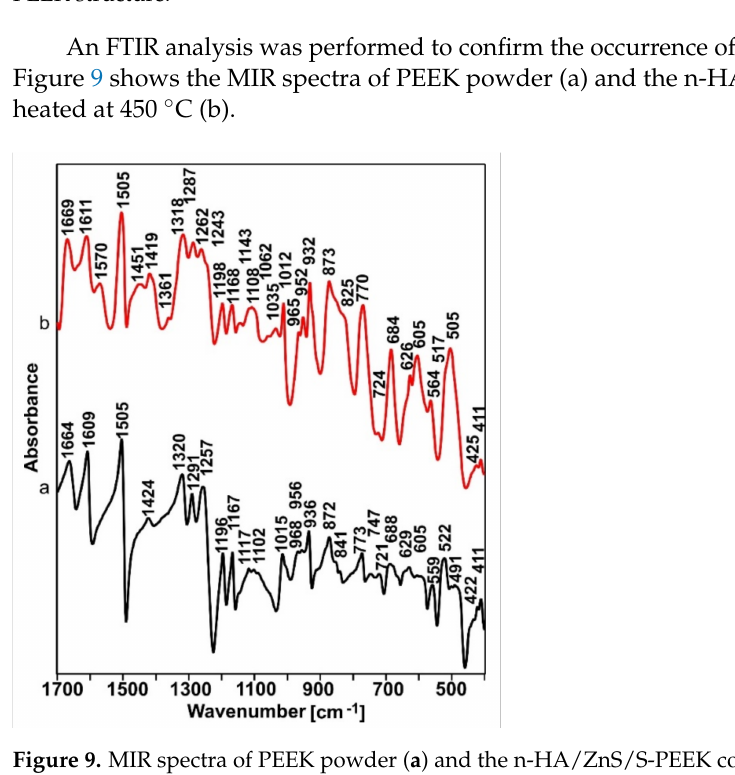
Figure 8. XRD patterns of n-HA/ZnS/S-PEEK coated alloy heated at 450 ◦ C showing an amorphous PEEK structure.